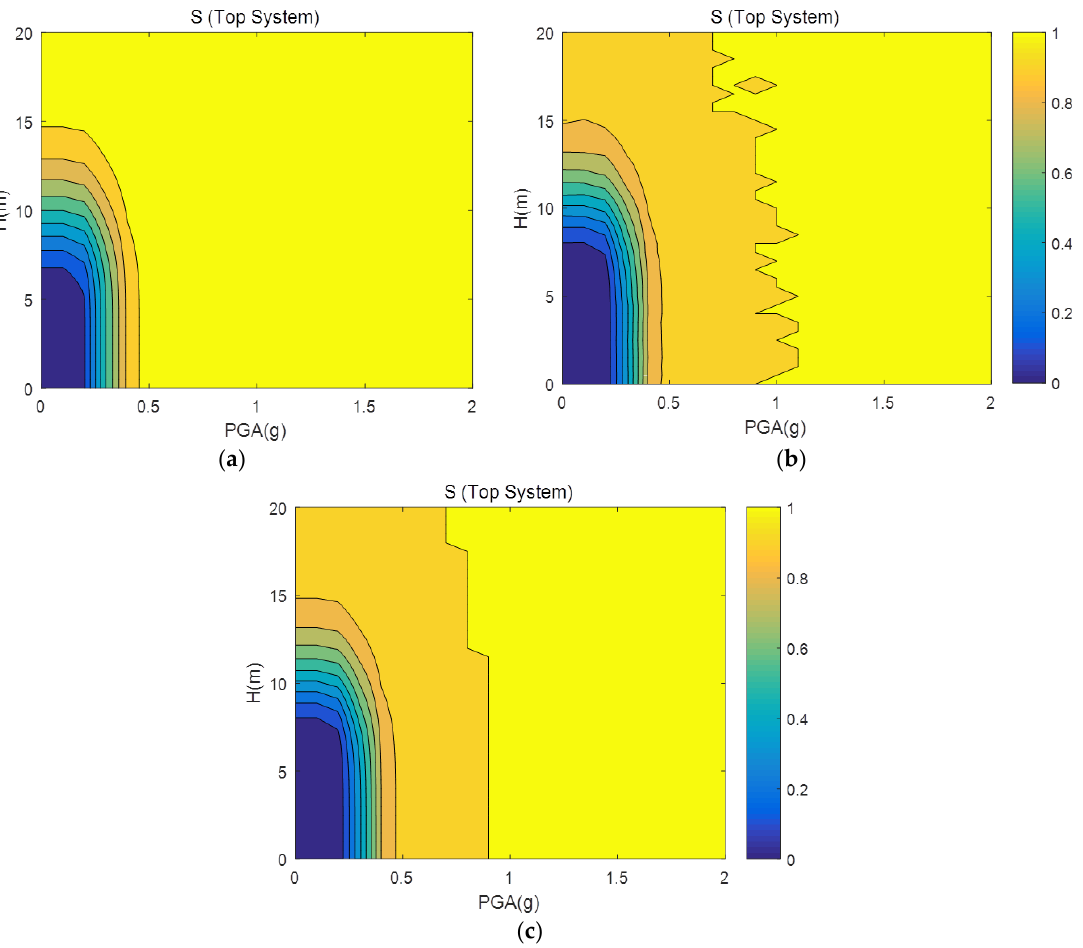
Figure 8. Comparison of multi-hazard system fragility results regarding the example (C1 ∪ C2) ∩ C3 ((1) independent condition): ( a ) Boolean; ( b ) E-DQFM; ( c ) proposed (I-DQFM).